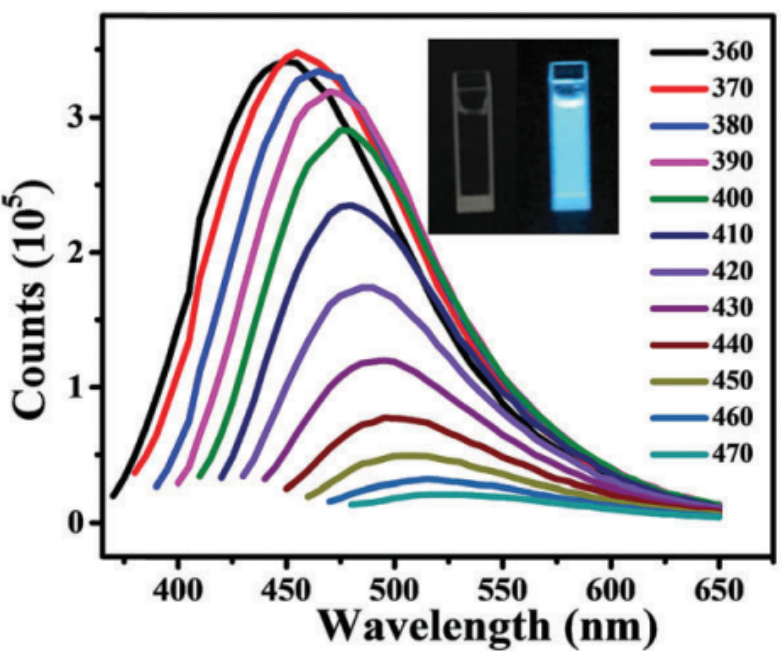
Figure 11. The photoluminescence spectra of Ti 3 C 2 quantum dots under different excitation wave- length. (Reproduced with permission from ref. [167]. Copyright 2018 RSC Publications.).